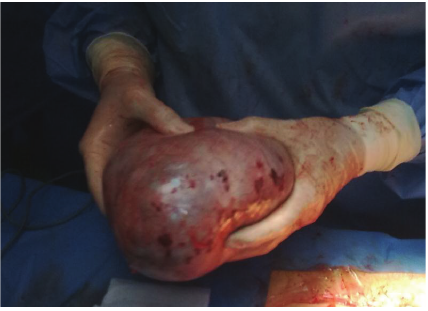
Figure 3: Gross photograph surgical specimen shows tumor, mea- suring 19 × 17 × 16cm in the left